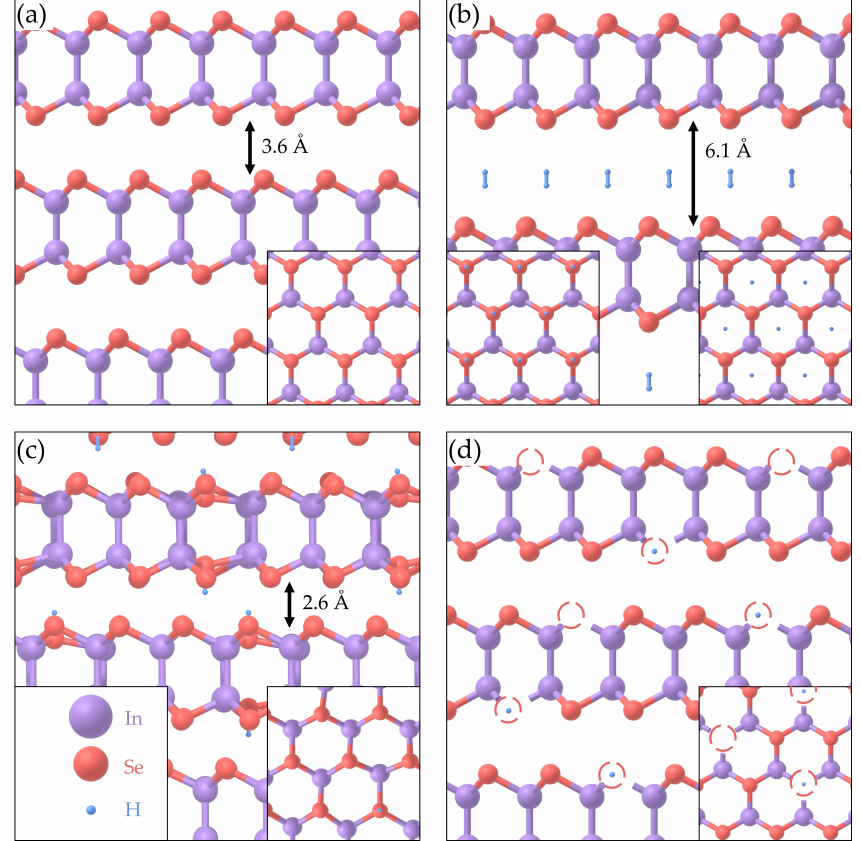
Figure 1. Crystallographic structures for: ( a ) Pristine bulk γ -InSe viewed in plane and (inset) out of plane. ( b ) Bulk γ -InSe containing H 2 , as computed using density functional theory (DFT), viewed in plane and (inset) out of plane. ( c ) Bulk γ -InSe with atomic hydrogen bonded to Se, as computed using DFT, viewed in plane (inset) out of plane. ( d ) Proposed structure of bulk γ -InSe with Se vacancies, some of which contain atomic hydrogen, as viewed in plane and (inset) out of